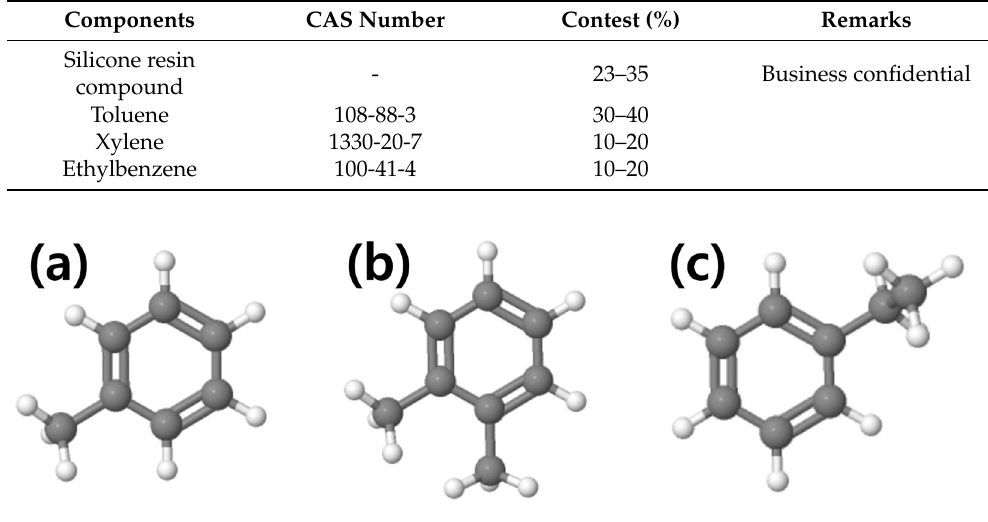
Figure 8. Chemical structures of organic solvents in resin mixtures. ( a ) toluene, ( b ) xylene, ( c ) ethylbenzene. ( c )